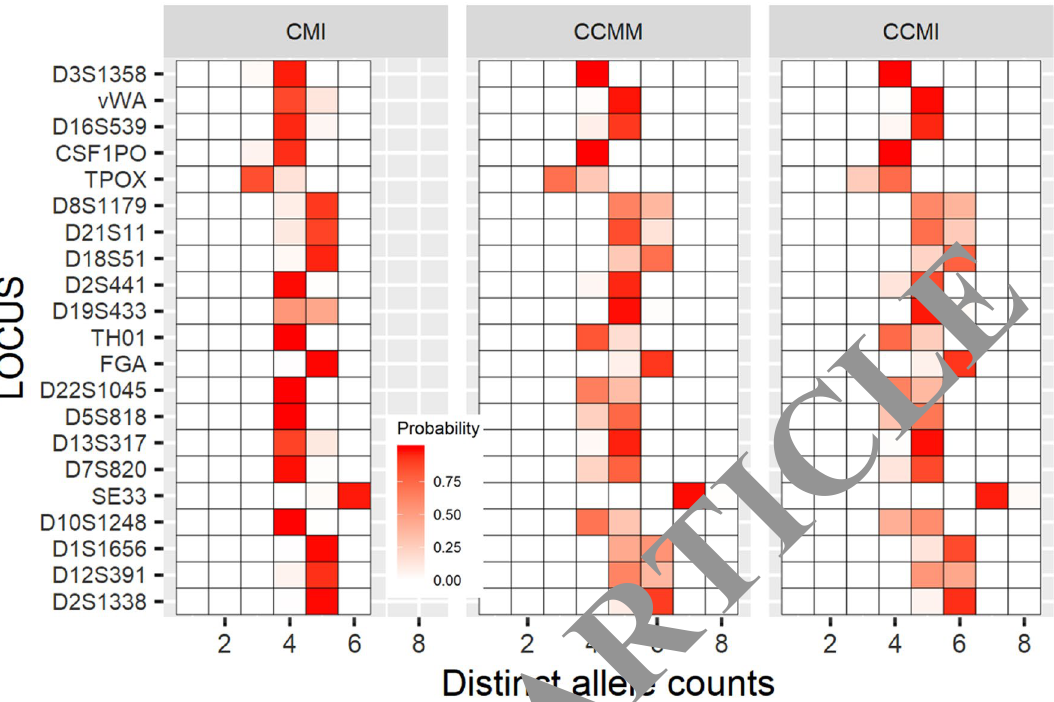
Figure 3. Heatmap of distinct allele counts generated from simulation using a mixture of ethnic population, without considering allele dropout. The probabilities of observing different numbers of distinct alleles obtained in a DNA mixture are displayed. CMI refers to a 3-person mixture DNA profile created from a combination of one contributor each from the Chinese, Malay, and Indian ethnic population. CCMM refers to a 4-person mixture DNA profile created from a combination of two contributors each from the Chinese and Malay ethnic population. Similarly, CCMI refers to that from a combination of two contributors from the Chinese, and one contributor each from the Malay and Indian ethnic